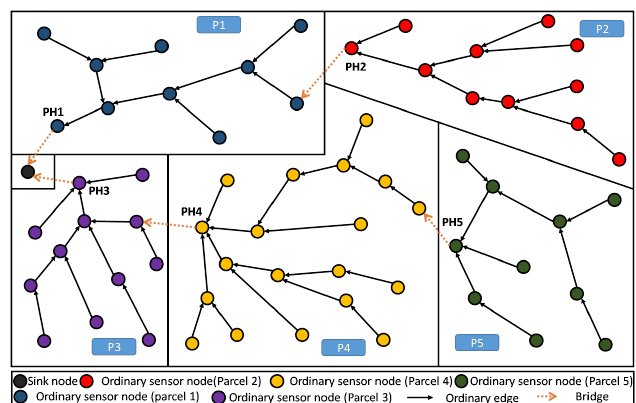
Figure 4. DODAG resulting from Partition Aware (PA)-RPL deployed in a sample farmland—5 duly covered